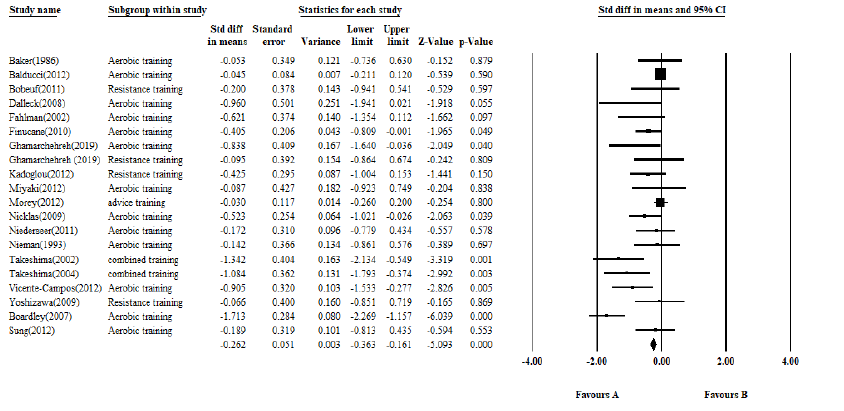
Figure 3. Effects of training on LDL (mg/dL), forest plot showings pooled mean differences with 95% CIs for 19 effect sizes obtained from 20 trials (two distinct effect sizes for various modalities were prepared by Ghamarchehreh et al)